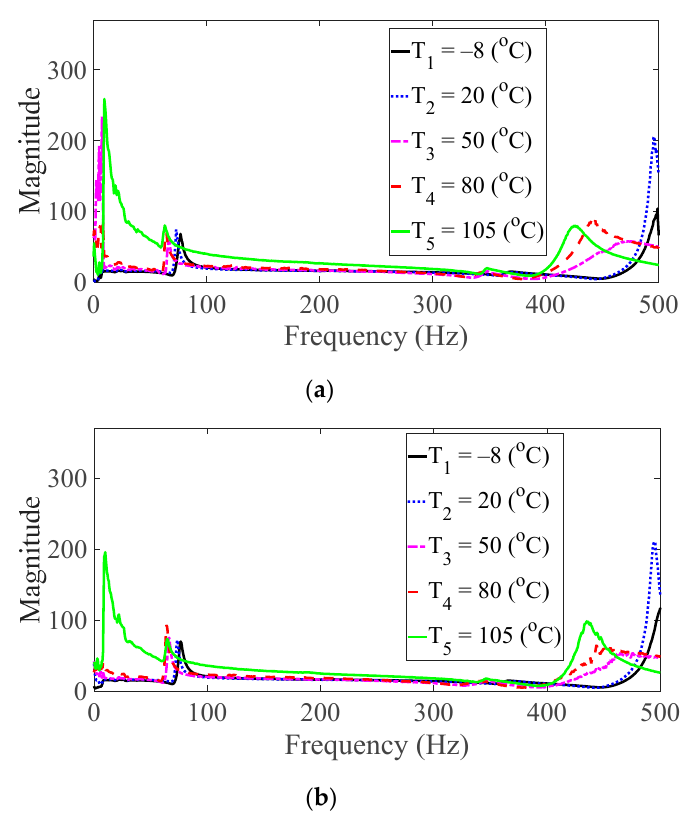
Figure 9. Measured FRFs with θ = 90°: ( a ) p = harmonic and ( b ) p = random. Table 4. Variation of the resonance frequency ( ω n ,1 ) according to different parameter conditions. Harmonic θ